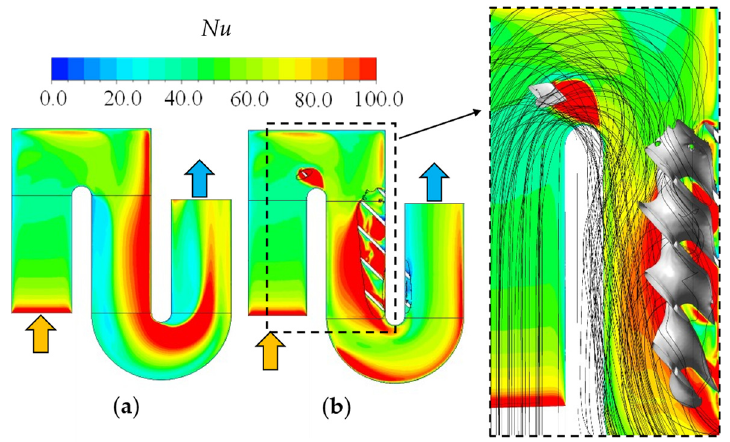
Figure 23. Nusselt number contours of the serpentine channel: ( a ) baseline model; ( b ) TO model with diamond ‐ TPMS structure.